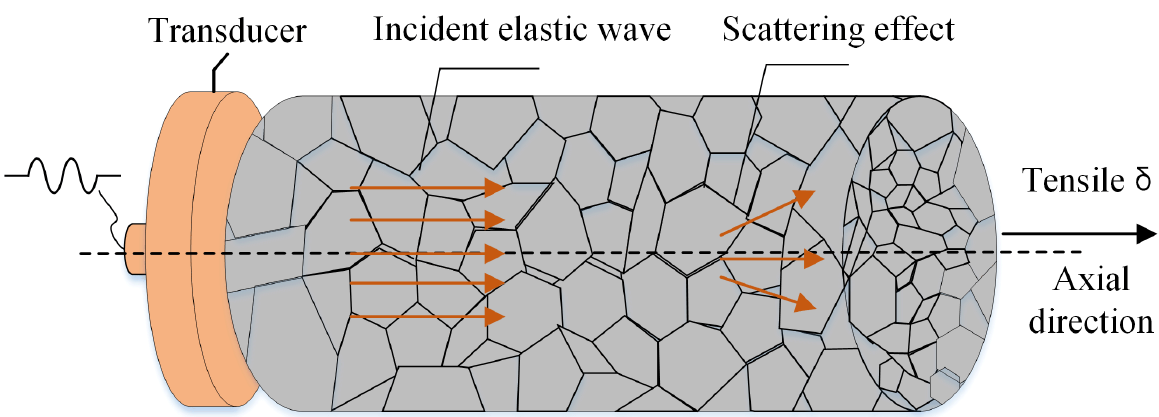
Figure 1. Ultrasonic wave propagation in bolt under the axial